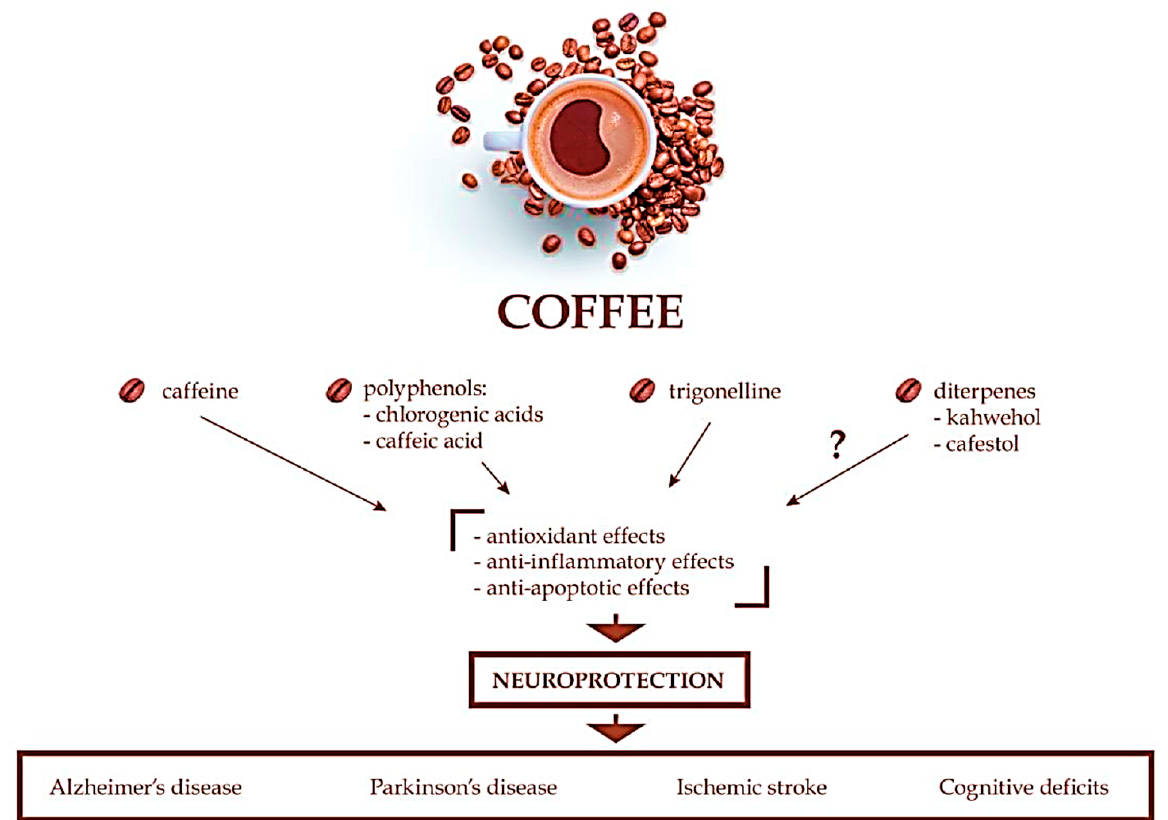
Figure 1. Summary of the neuroprotective effects of coffee [1]. (Soca ł a 2021).